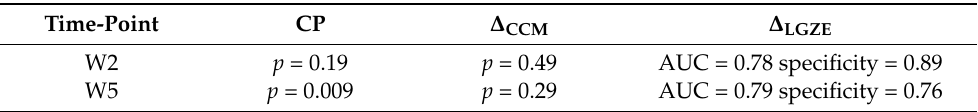
Table 4. Prediction of treatment outcome in the validation cohort: progression free survival by CP progression free survival by ∆ CCM and local recurrence by ∆ LGZE